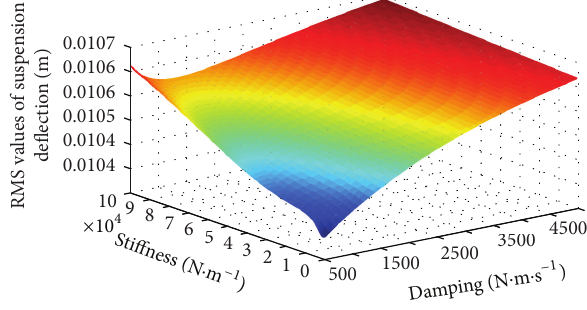
Figure 7: RMS map of suspension deflection.